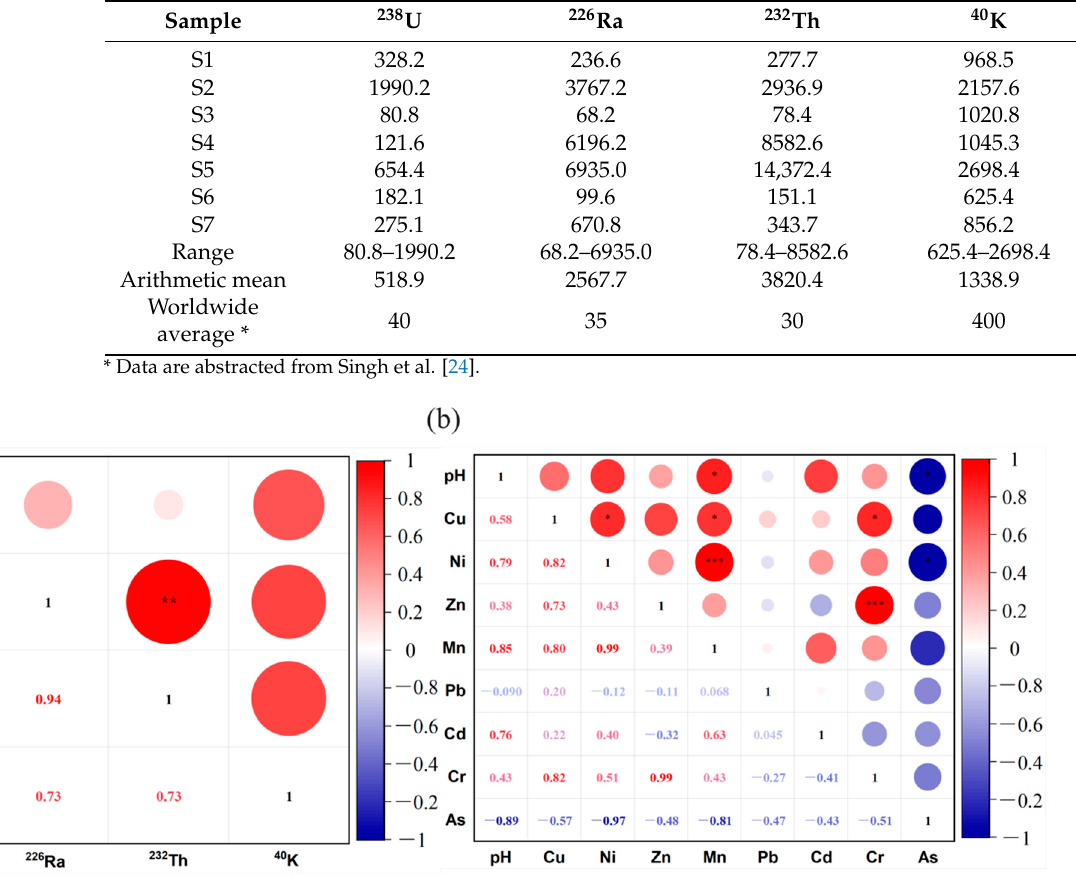
Table 2. The activity concentrations of 238 U, 226 Ra, 232 Th, and 40 K in surveyed soil samples in decommissioned REE processing plant (Bq · kg − 1 ).